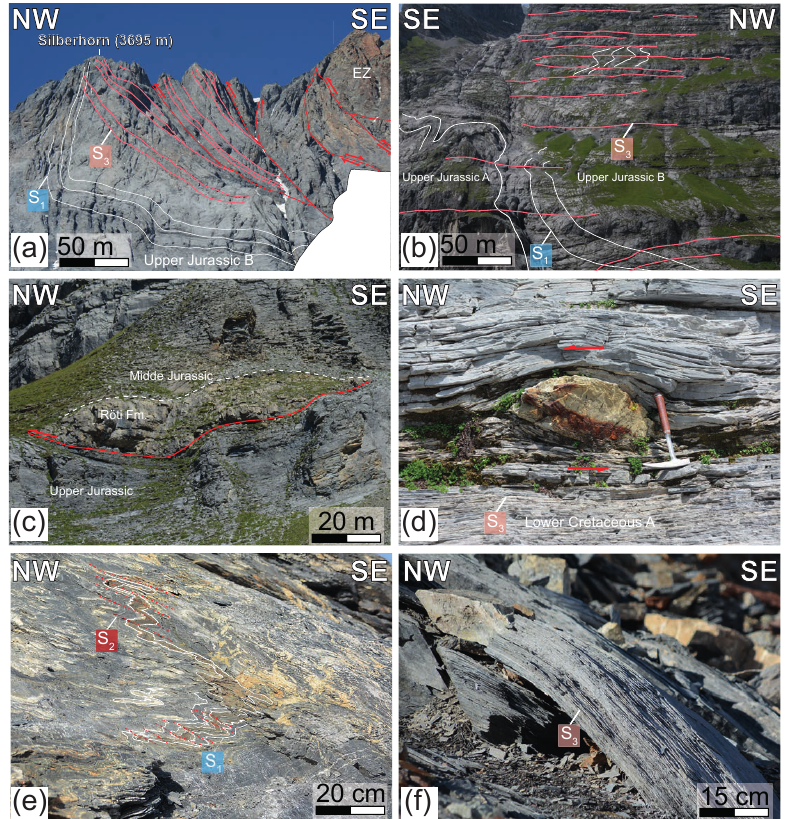
Figure 7. Field examples of key deformation structures within the sedimentary rocks. (a) Modulation of the previous foliation (S1, white lines) by the latest stage fault system (solid red lines) and the contemporarily induced foliation (S3, pink lines) in the summit region of the Jungfrau. (b) Similar overprinting of already folded bedding by the younger foliation east of the Eiger summit in a lower level (elevation around 2500ma.s.l). (c) Decameter-sized dolomite boudin of the Triassic (Röti Fm.) marking the shear zone at its base in the RT (Rottal) region, which is the roof thrust of the autochthonous cover unit. (d) Decimeter-sized sigma clast of boudinaged iron-rich nodules (siderolithic unit) within the ductile host rock mylonites that marks a shear zone in the west flank of the Eiger mountain. (e) Local modulation of the initial foliation and folds by steep SE-plunging axial planes with foliation, inflicted during the intermediate step of deformation (Ha). (f) Carbonaceous ultramylonite in the MJ transect, some decameters above the location of panel (e) , showing the strongly localized, latest overprint, completely transposing traces of previous